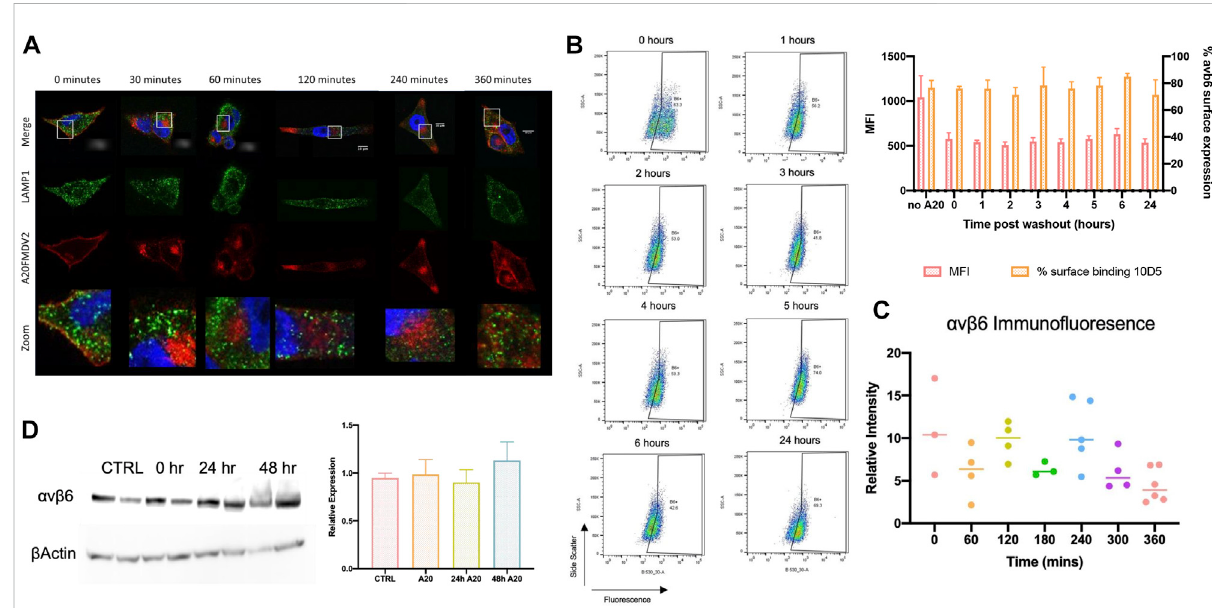
FIGURE 6 α v β 6 degradation post-endocytosis. (A) Representative images show the distribution of A20FMDV2 (red) and LAMP1 (green) in A375 β 6 cells following Cy5-(GS)5-bioA20FMDV2 internalisation. LAMP1 staining is consistent in each time point, with no indication of changes over time (up to 360 min). (B) α v β 6 surface expression was monitored using 10D5 by fl ow cytometry (example dot-plots and summary histogram shown) post- exposure to A20FMDV2 up to 24 h after wash-out, with no signi fi cant differences observed in expression over this time course in the percentage of cells bound to α v β 6. There was a signi fi cant reduction in MFI of 10D5 binding with and without A20FMDV2 pretreatment ( n = 3). (C) Quanti fi cation of 62OW staining intensity from images acquired in Figure 5, revealing no signi fi cance in the intensity up to 6 h